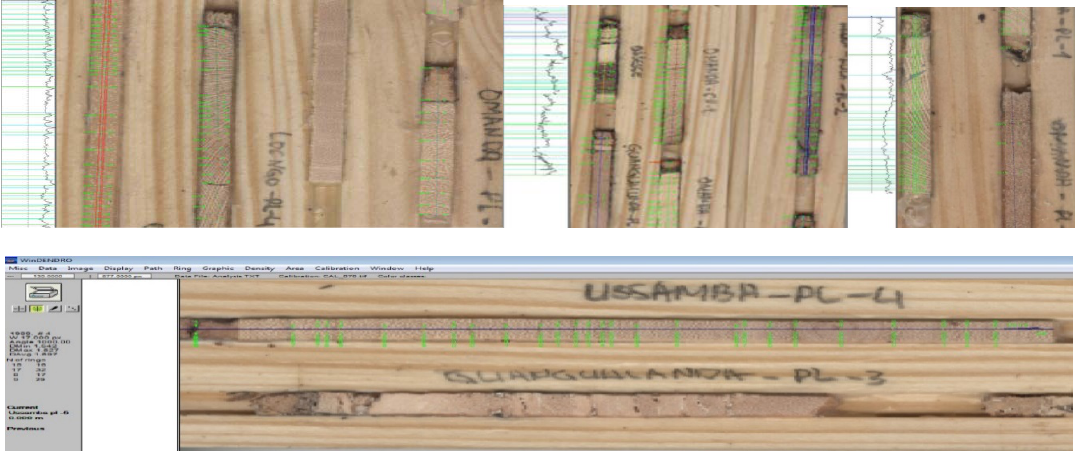
Figure A2. Illustration of an Image with Tree Rings Analysis in WinDENDRO TM.